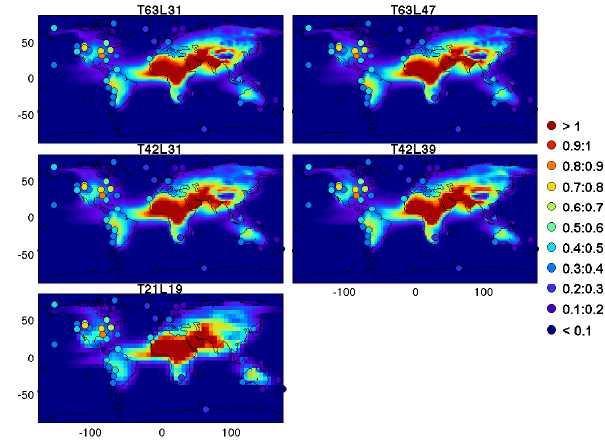
Fig. 3. 1998–2002 mean surface air concentration of 210 Pb (mBq m − 3 STP) with different model resolutions. The dots show the lo- cation and observed concentration of the measurement stations (ref- erences given in the text).